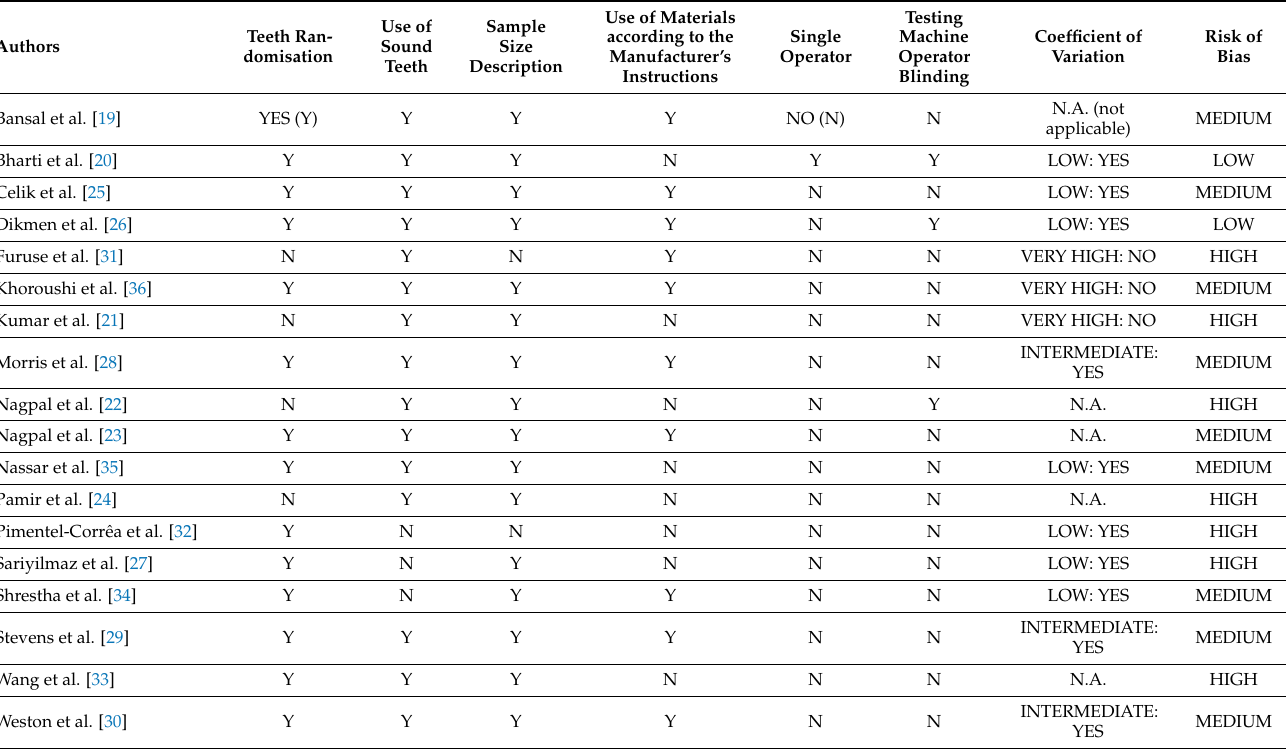
Table 3. Risk of bias in each